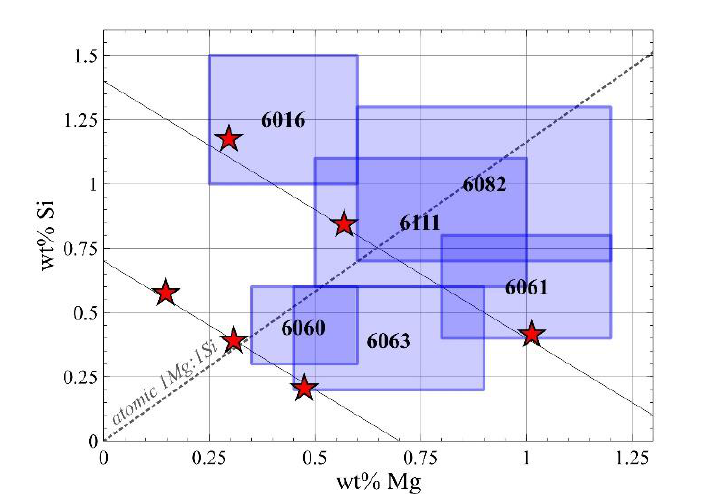
Figure 1. Experimental alloy Mg and Si contents in relation to common 6000 series alloys.